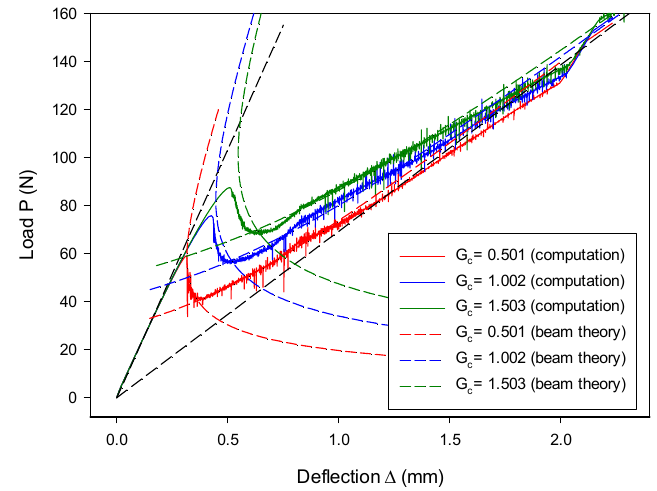
Figure 20. Load–deflection (P ∼ ∆ ) histories vary as a function of critical energy release rate G c .